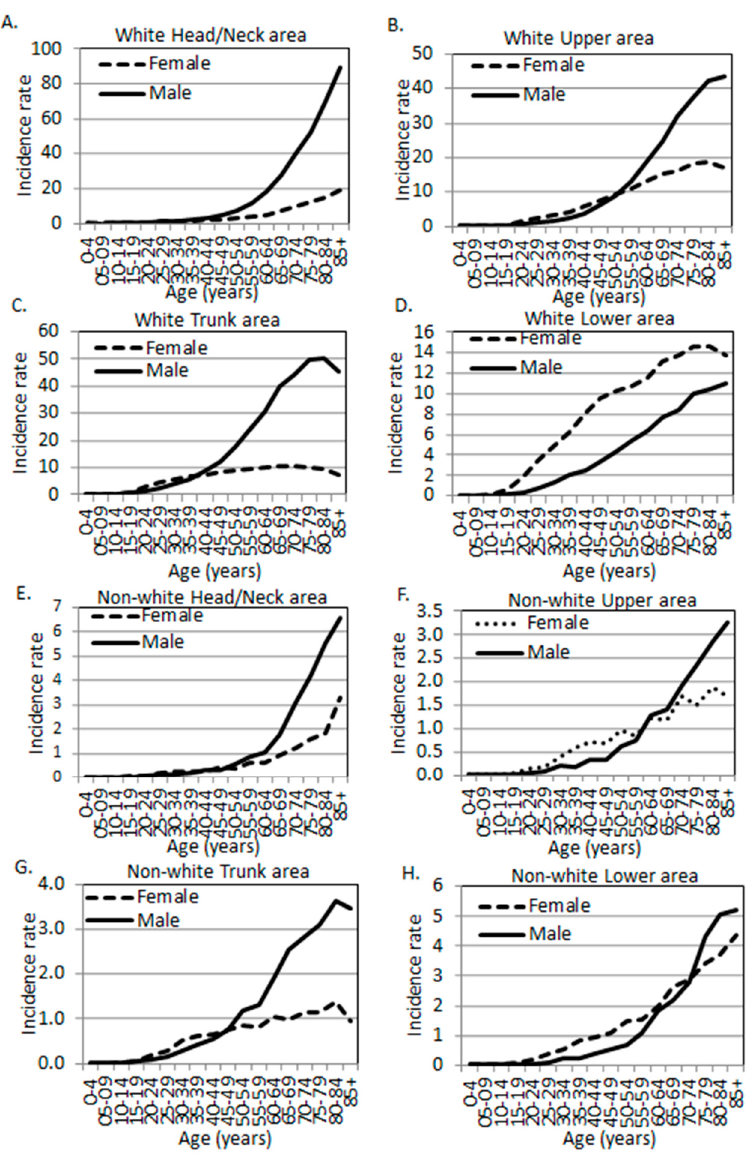
Figure 1. Melanoma incidence rates by age, sex, and anatomic site. ( A – D ) White population. ( E – H ) Non-white populations. ( A , E ) Head and neck area. ( B , F ) Upper limbs and shoulder area. ( C , G ) Trunk. ( D , H ) Lower limbs and hip area (SEER 18 data, 2000–2015).